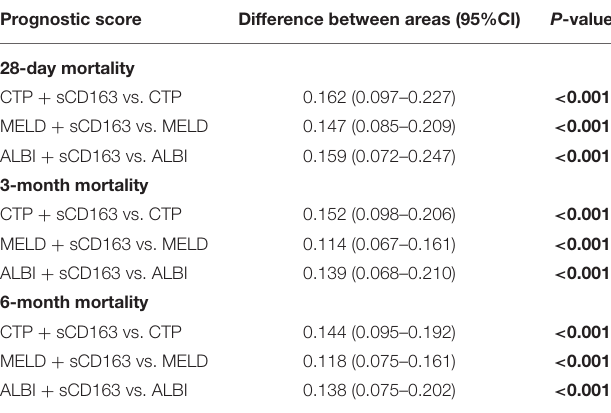
TABLE 6 | The predictive value of various scores with adding sCD163. Prognostic